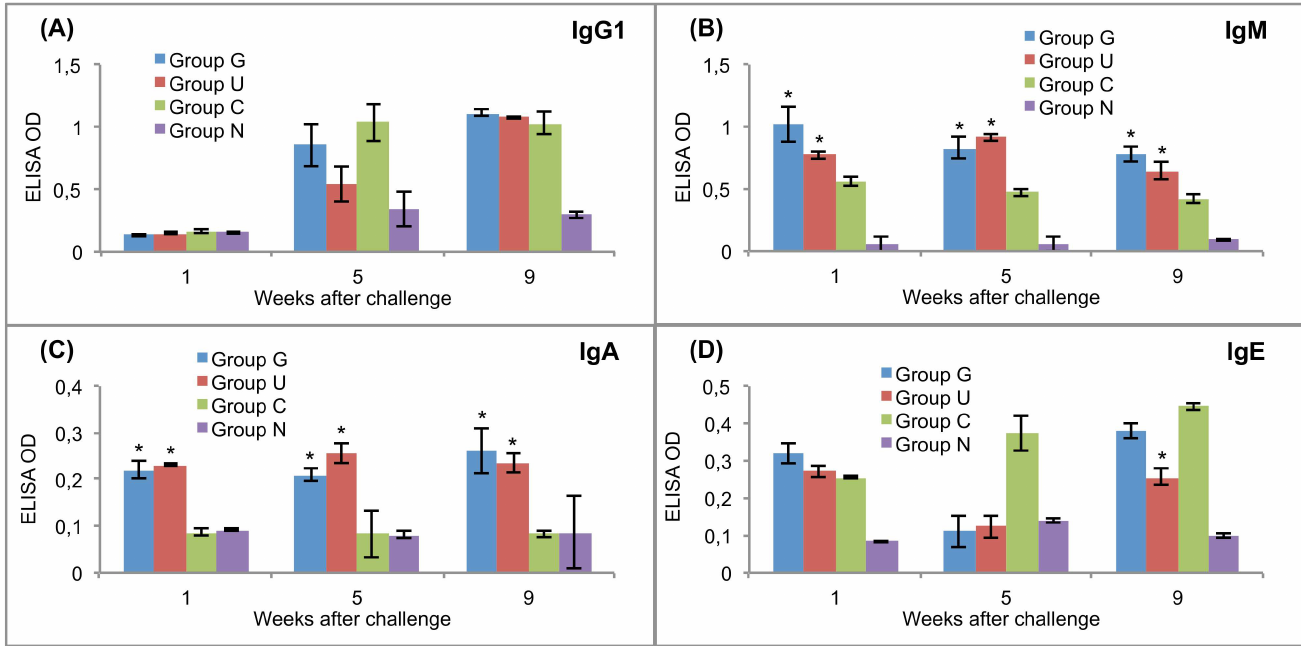
Fig 3. Post-challenge serum antibody isotype responses of vaccinatedand control rats to ES products of adult flukes. (A) IgG1. (B) IgM. (C) IgA. (D) IgE. Group G–Lyophilisedlettuce expressingthe mature CPFhW enzyme flankedby Gly-rich linkers; Group U–Lyophilised lettuce expressing the mature CPFhW protein fused with ubiquitin;Group C–Lyophilised control lettuce; Group N–None.At each timepoint, four rats from each group were euthanised and dissected. * Indicatessignificantly increasednumbers of cells ( p < 0.05). Error bars indicatestandard